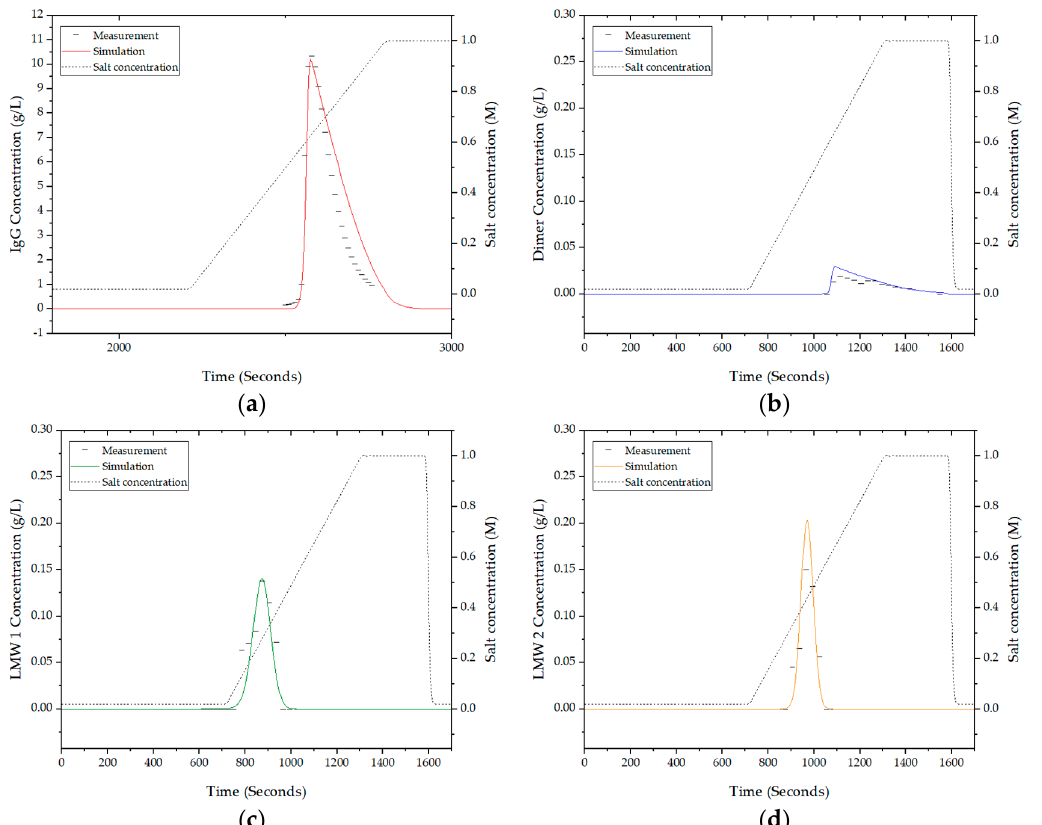
Figure 13. Results of parameter estimation ( a ) is monomer, ( b ) dimer, ( c ) LMW 1 and ( d ) LMW 2. Simulation results are given as lines, fractions are given as dashes.